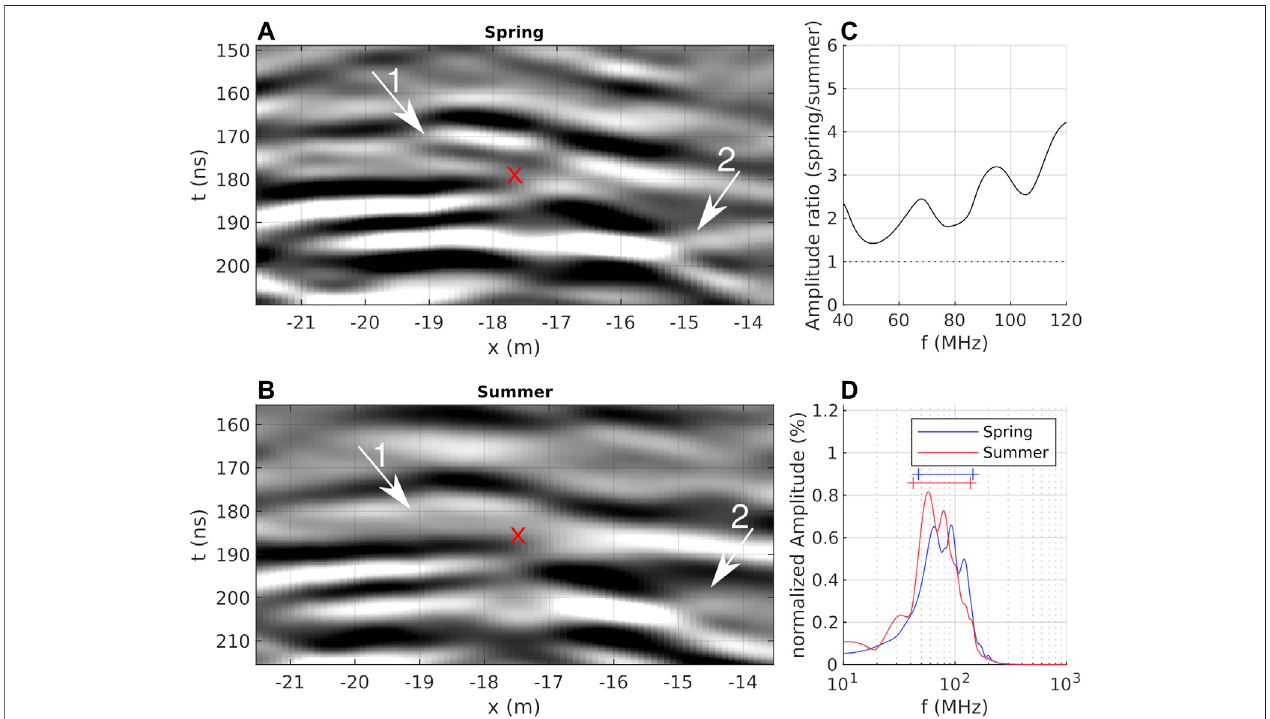
FIGURE 8 | Exemplary 2D detail in time (A,B) and frequency domain (C,D) . 2D data were extracted from our migrated (A) spring and (B) summer data cube (betweenx= − 22and − 14 m,aty=21 m),andmanuallyalignedbasedonimagedetails(redmarkeratcenter).Note,againfactoroftwohasbeenappliedtothesummer data for visualization. Right column: (C) ratioof unnormalized amplitude spectra around ournominal antenna frequency and (D) normalized amplitude spectra for spring (blue)andsummer(red) data.In (D) ,horizontallines denotefrequencyrangebetween10thpercentileA 10 and90thpercentile A 90 (comprising80%oftherecorded amplitudes). Arrows identify features that are further discussed in the